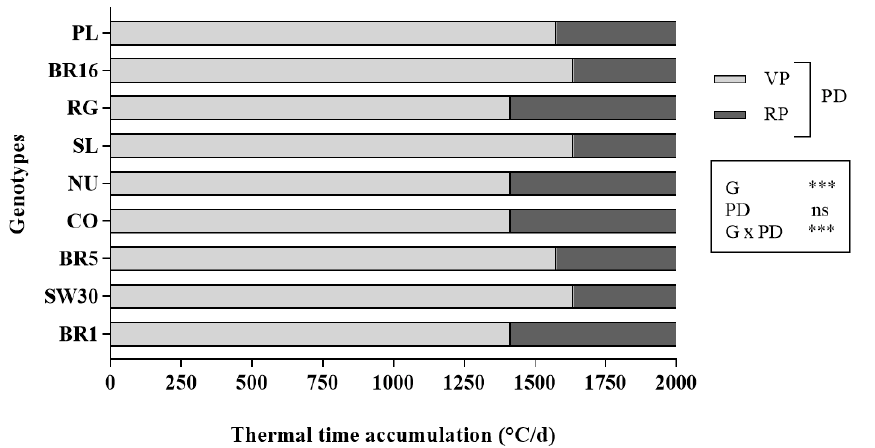
Figure 1. Effect of genotype (G) and plant development (PD), consisting of a vegetative (VP) and reproductive phase (RP), on the thermal time accumulation (°C d − 1 ). The significance of variability factors according to the F-test: ns, not significant; ***, significant at p ≤ 0.001 level. Genotype (G), crop age (CA), harvest time (HT) and their reciprocal interactions significantly affected biometric and productive traits, except for (i) branching, which did not vary depending on CA, (ii) basal stem diameter, in relation to G × HT interaction and (iii) plant height and SLW which were not affected by CA×HT (Table 4).